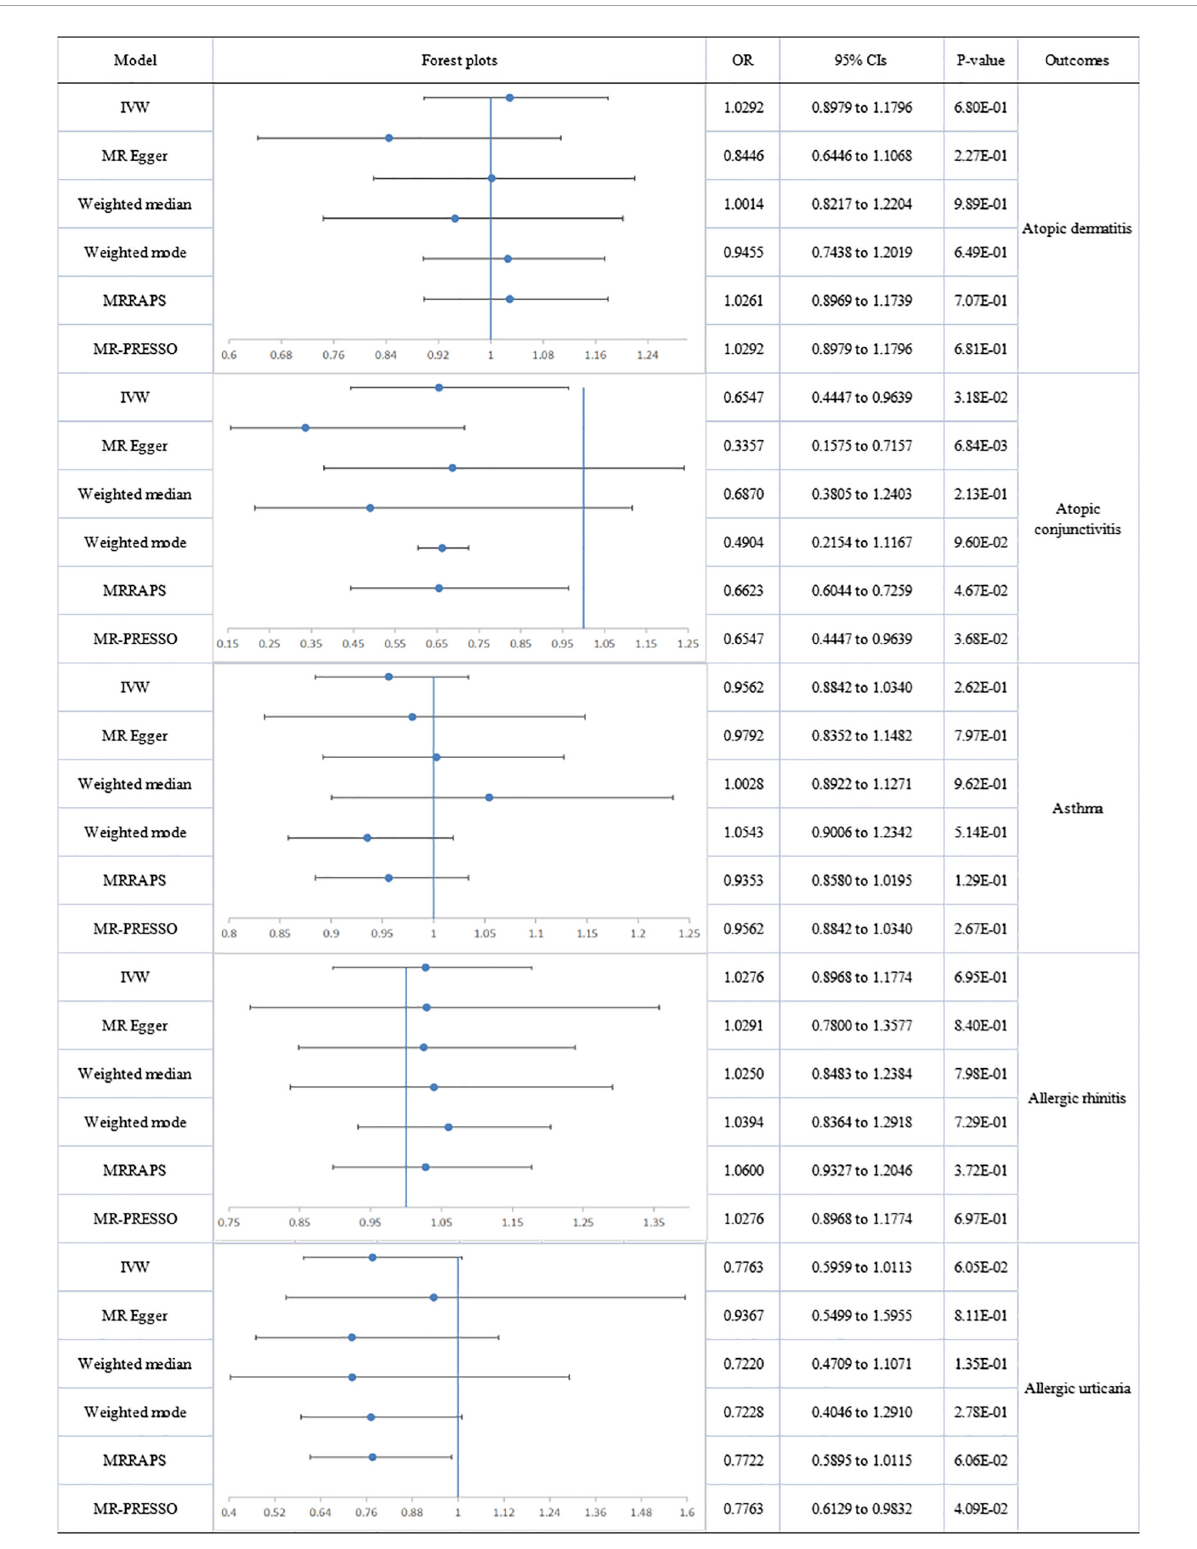
FIGURE3 The forest plot of univariable Mendelian randomization analyses exploring associations between omega-6 fatty acids and risk of allergic diseases using different Mendelian randomization statistical models OR: odds ratio; CIs: confidence intervals.